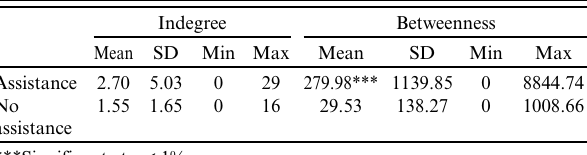
Table 2 . Wilcoxon rank-sum text between individual centrality and assistance to advisory committee meetings (n = 198).